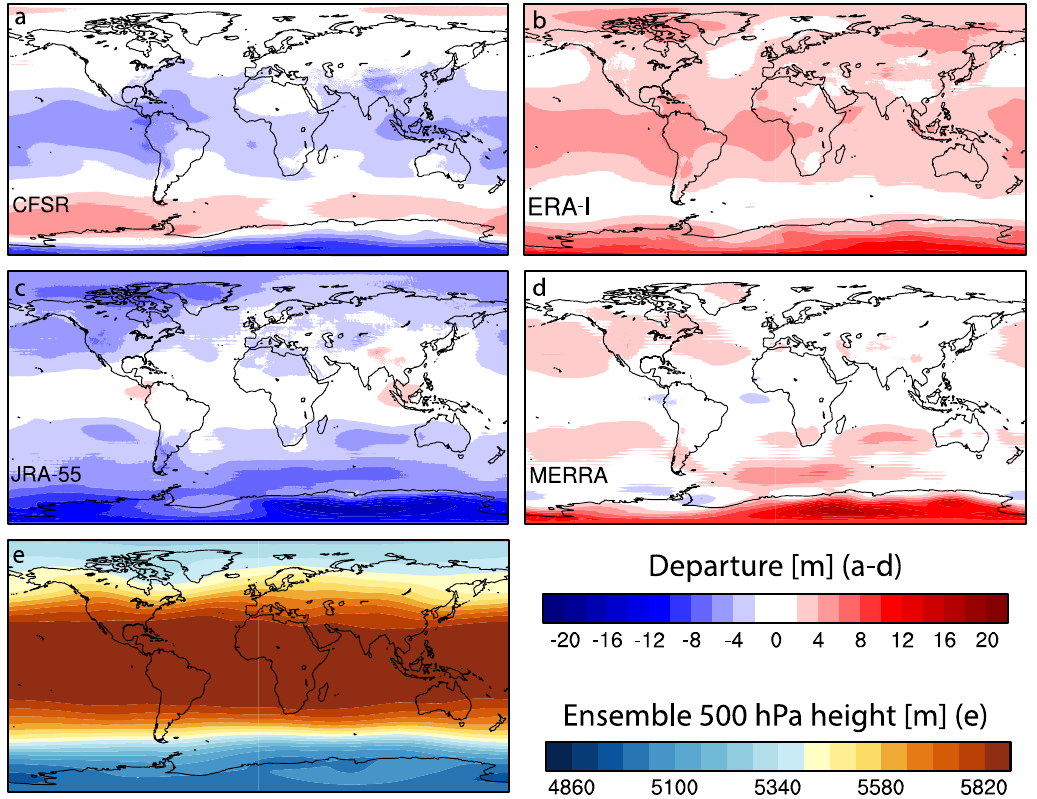
Figure 9. ( a – d ) The difference of 500-hPa geopotential heights between the reanalysis and ( e ) the ensemble, reanalysis subtract the ensemble over the 1981–2010 period. Horizontal-line artifacts in maps ( a – d ) are inherited from regridding within MERRA, which was averaged into the ensemble.